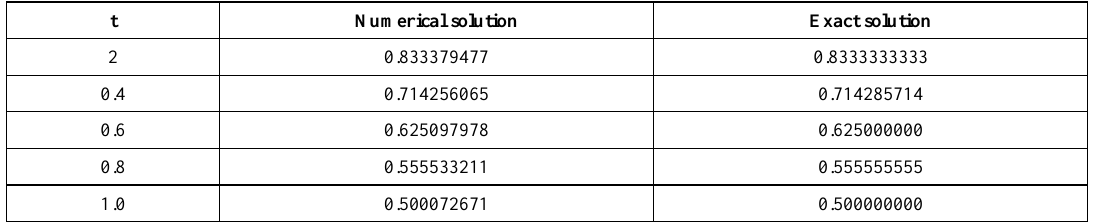
Table 1. Numerical comparison of the exact solution and the solution obtained by the present